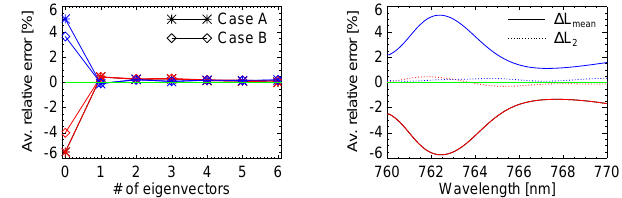
Fig. 11. Left panel: error of approximated radiance (average over all viewing geometries) as a function of number of eigenvectors used, for both cases and both profiles (red lines: tropical profile, blue lines: polar profile) and a spectral channel located at 763nm. Right panel: error of L mean (solid lines) and L 2 (dotted lines) for case A (average over all viewing geometries), as a function of wave-